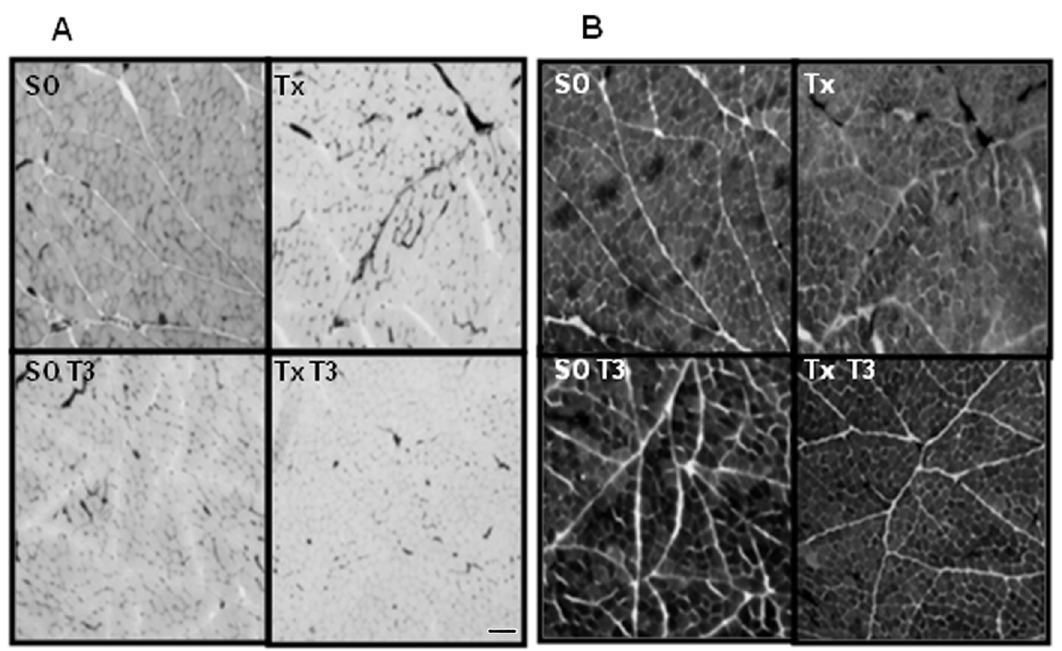
Figure 3. Effect of triiodothyronine (T3) on masseter muscle fiber types. Serial cross-sections of the masseter muscle from sham-operated (SO), thyroidectomized (Tx), sham-operated T3-treated (SO T3), and Tx rats chronically treated with T3 (Tx T3) illustrating the histochemical stains for myosin ATPase activity. The amount of T3 used was 5 μg/100 g body weight, for 15 days. Fiber types are identified as type I and II based on myosin ATPase histochemistry using different pre- incubation at different pH, namely 4.3 (Panel A) and 10.3 (Panel B). Type II fibers show myosin ATPase activity at alkaline pH (alkaline-resistant fibers: dark fibers) and absence of it at acid pH (acid-labile fibers: light fibers). Five animals per group were used. Bars = 100 μm.